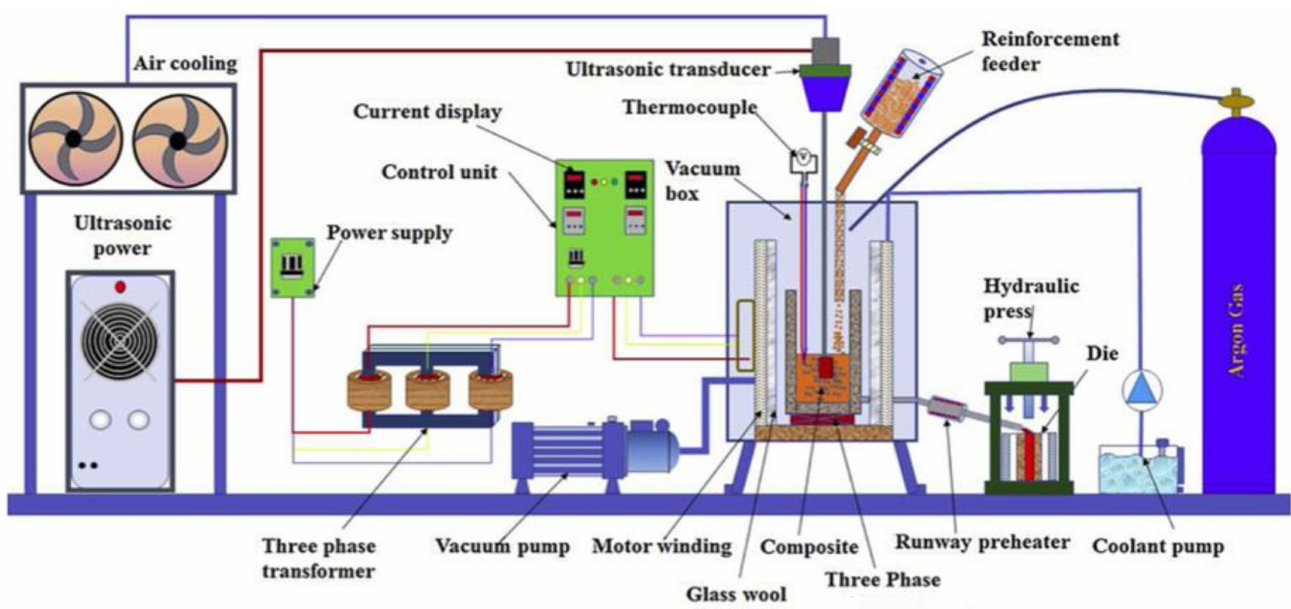
Figure 3. Stir casting furnace design